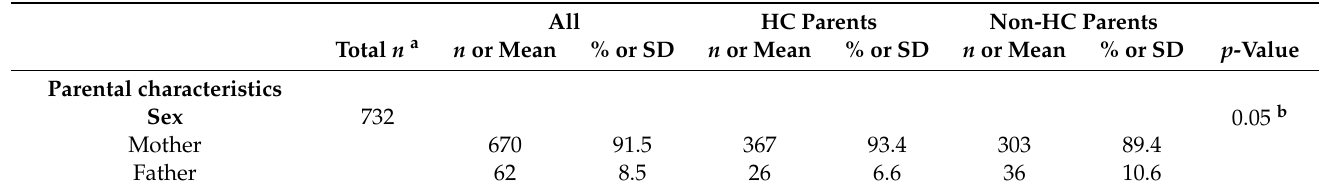
Table 1. Parental and child characteristics of all participants ( n = 738) and in groups of health- conscious (HC) and non-health-conscious (non-HC)